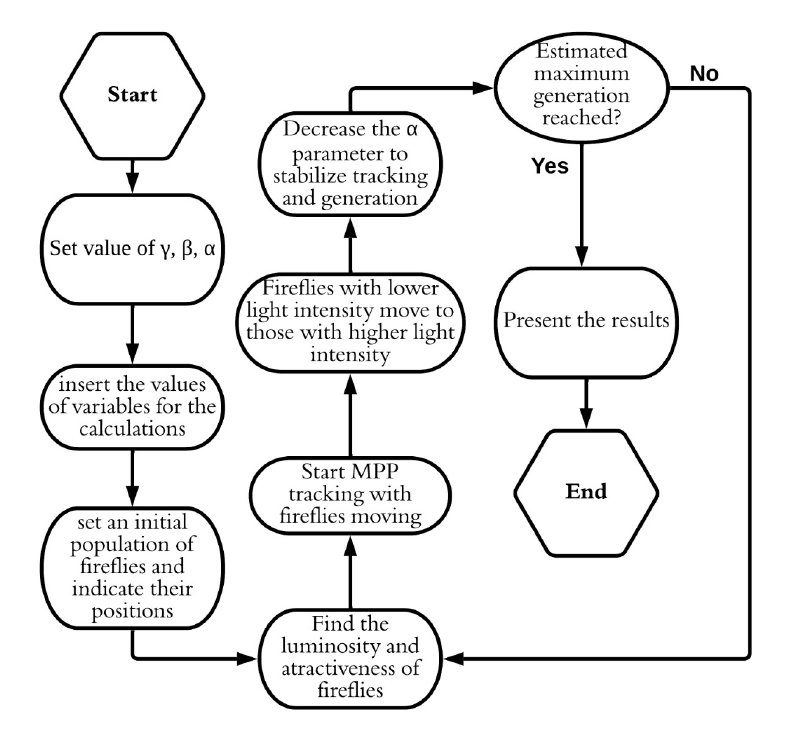
Figure 2. Flowchart of the FA optimization method.